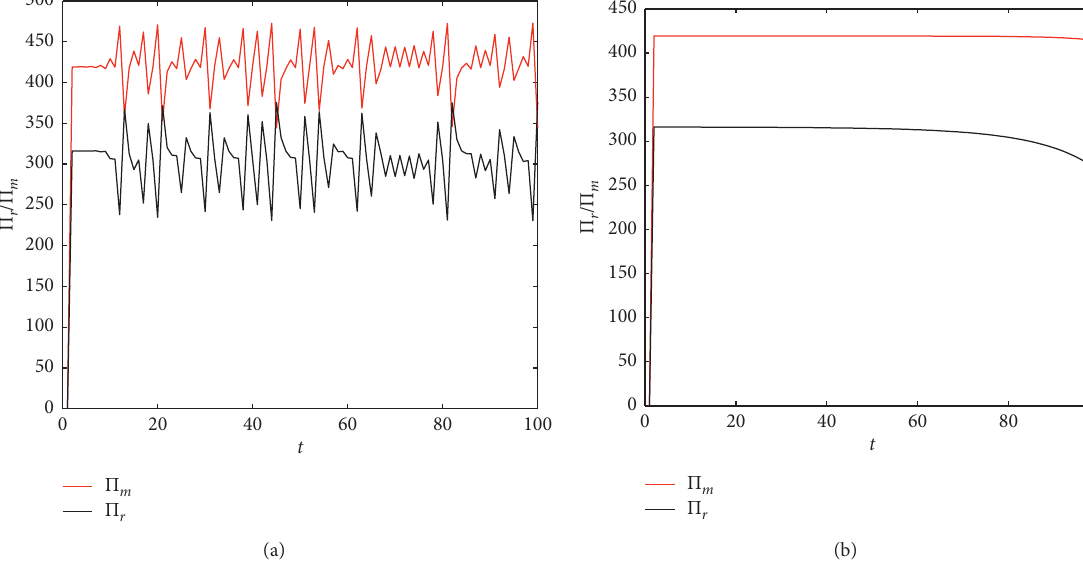
􏽑 r and m with respect to α 1 and α 2 . (a) α 1